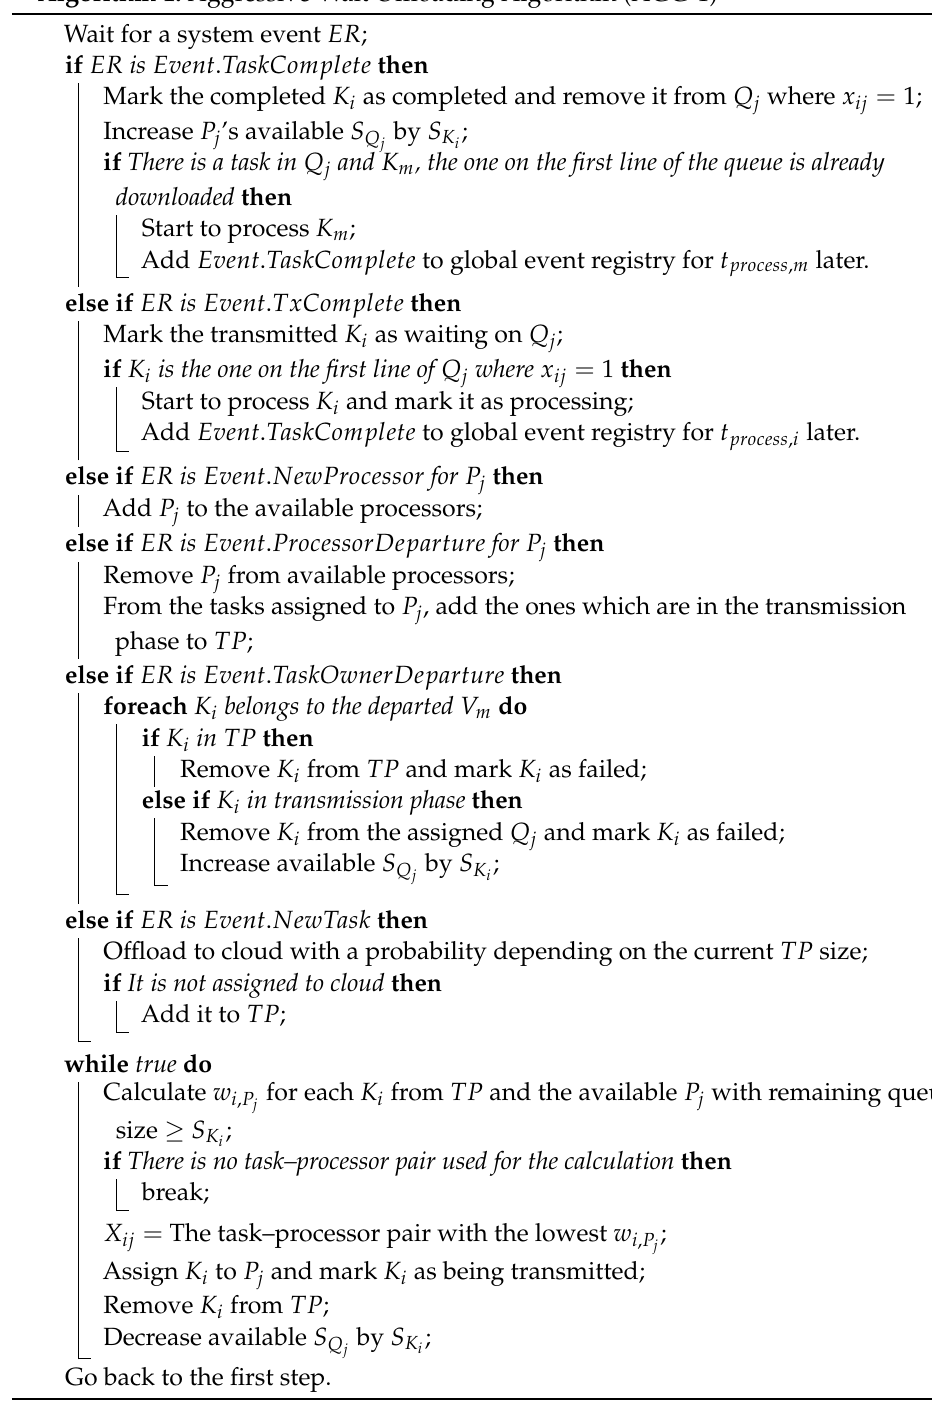
Algorithm 1: Aggressive-Wait Offloading Algorithm